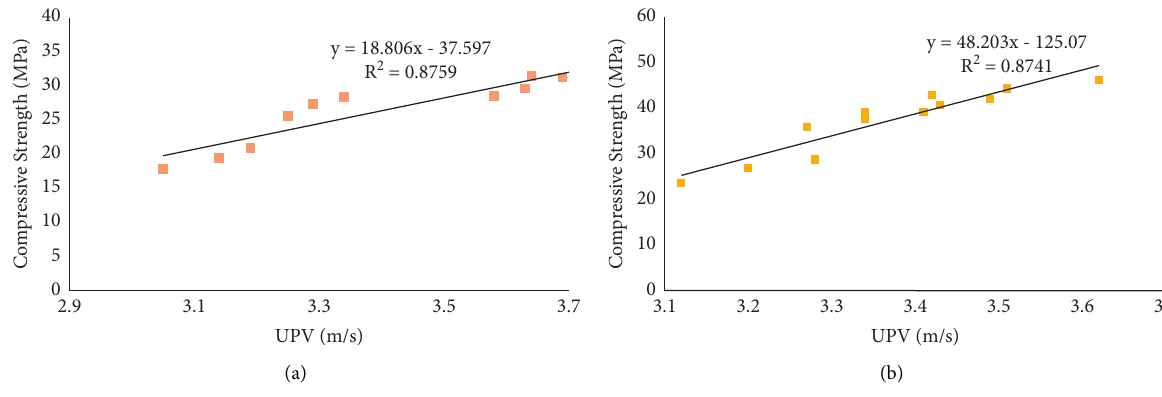
Figure 10: Relationship between compressive strength and